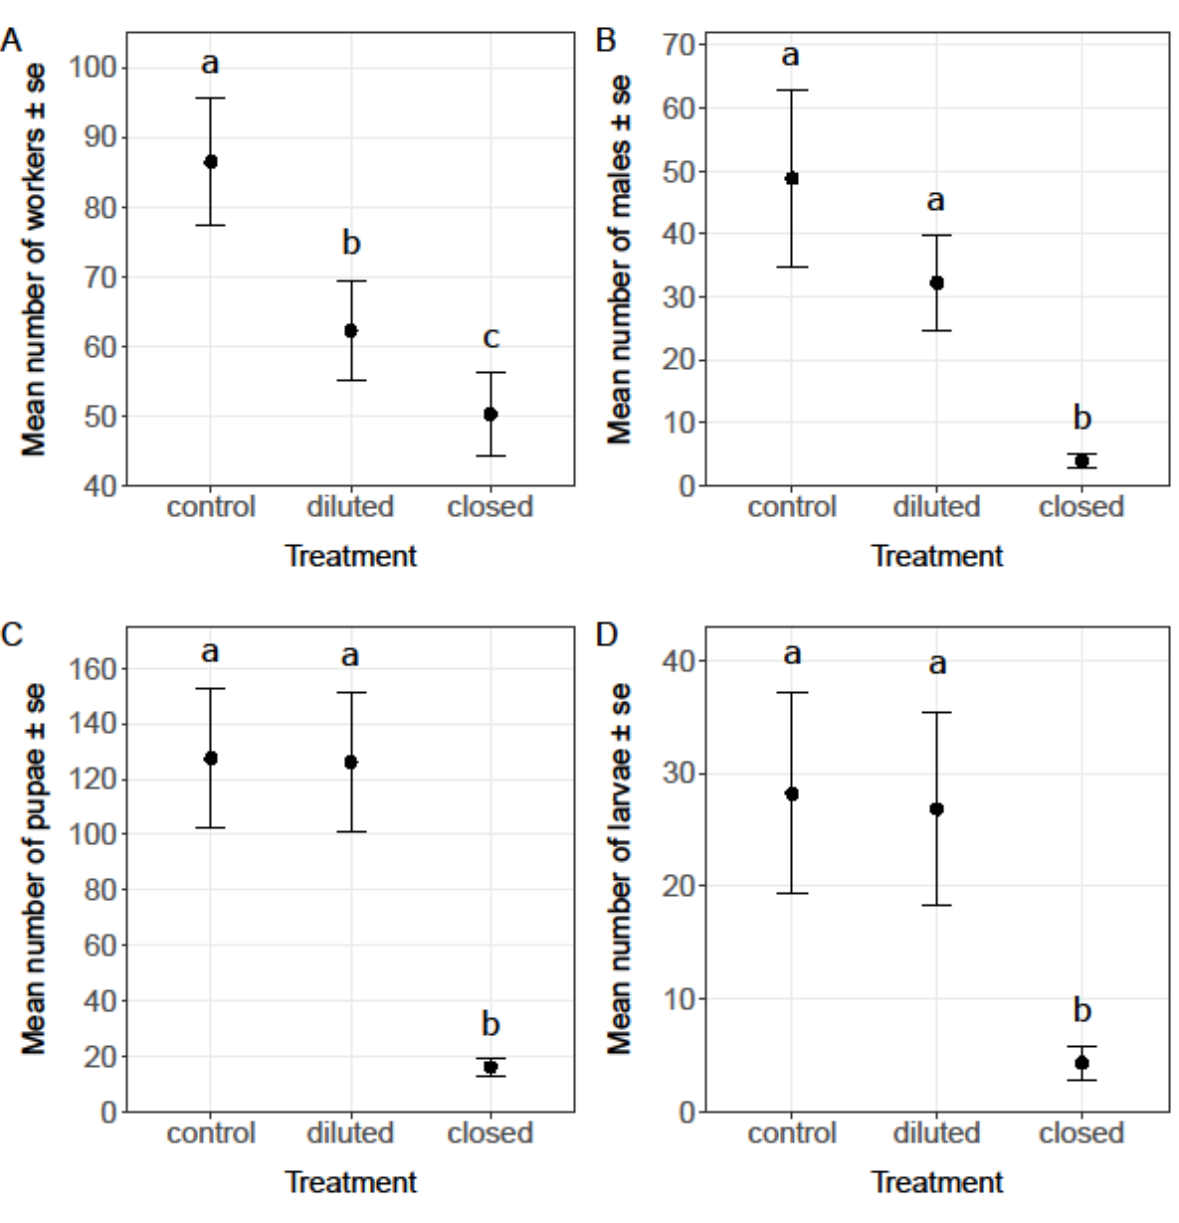
F IGURE 4. Mean number of B. terrestris (A) workers, (B) males, (C) pupae, and (D) larvae from each treatment group found in colonies